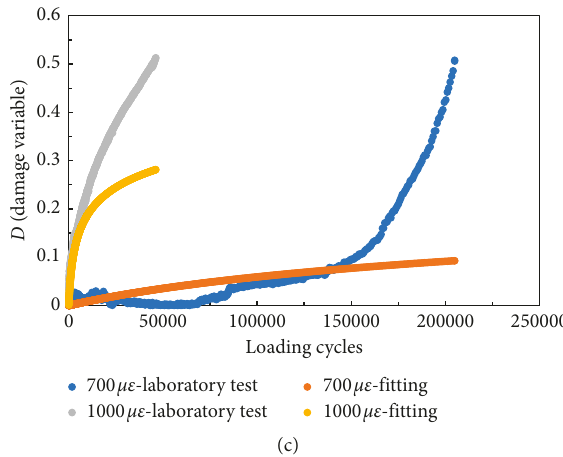
Figure 7: Fatigue performance prediction of the asphalt mortar at 5 ° C: (a) low asphalt content; (b) moderate asphalt content; (c) high asphalt content.